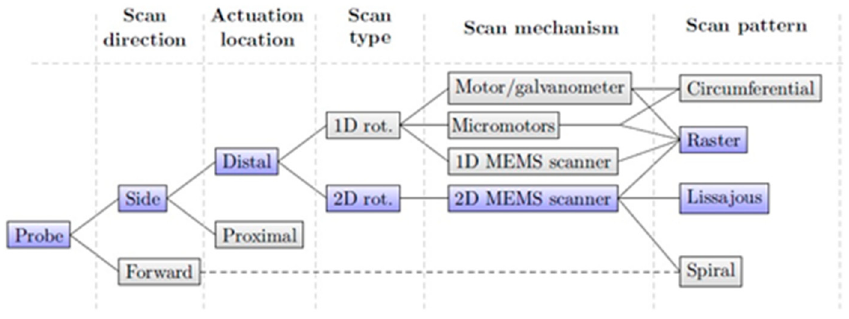
Figure 7. Order of criteria of classifications of the endoscopic probe configurations.